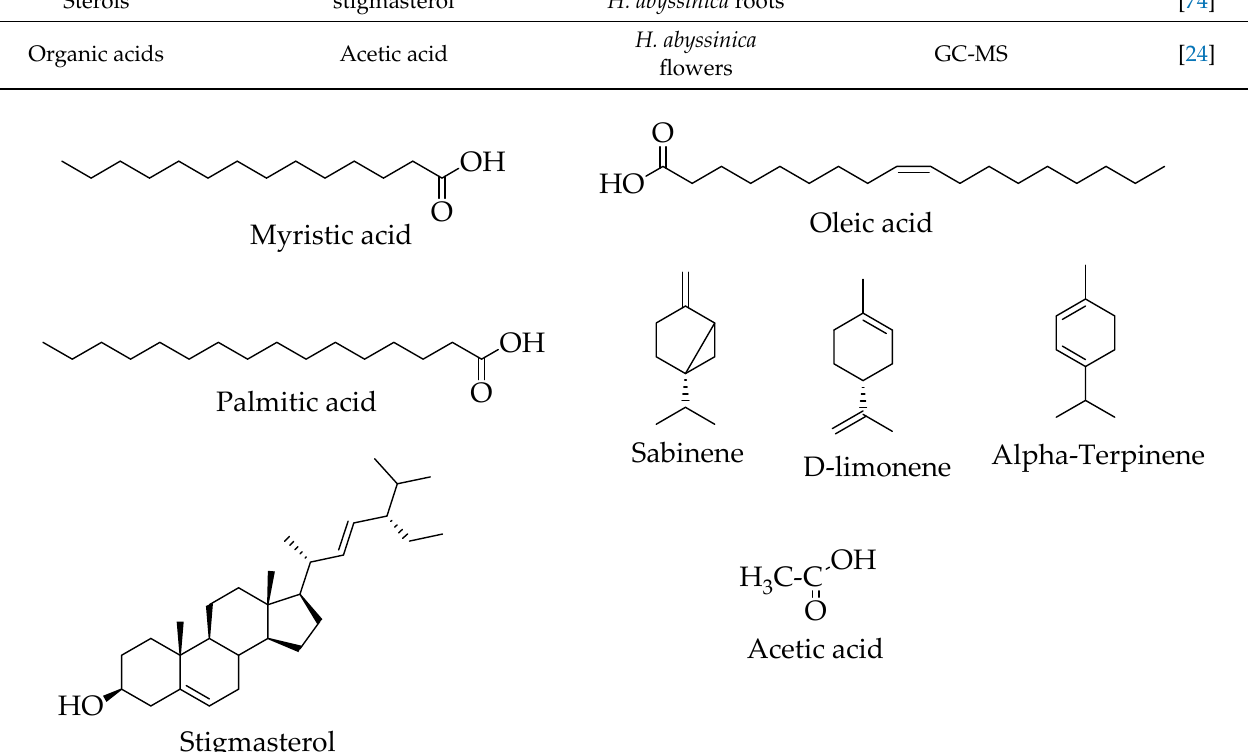
Figure 6. Chemical structures of H. abyssinica characterized using gas chromatography coupled with mass spectrometry (GC-MS) analysis.